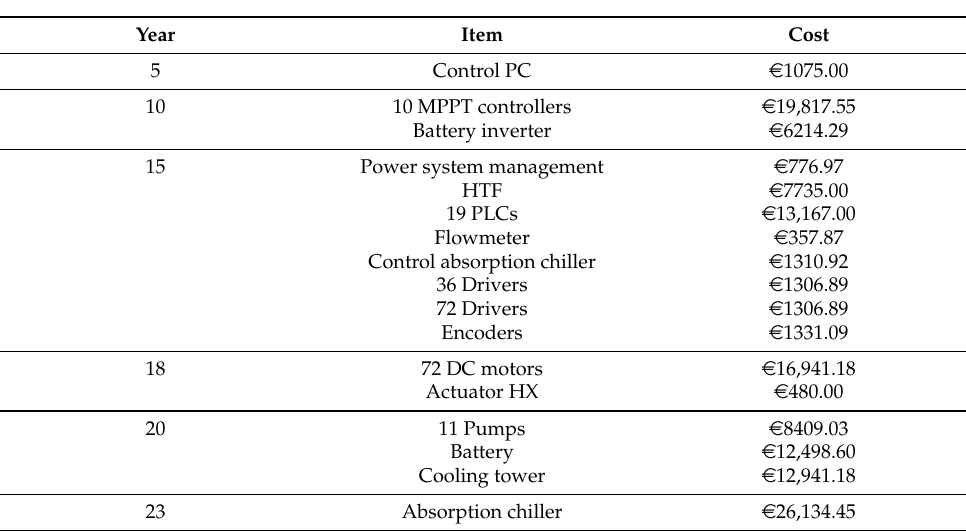
Table 8. Occurrence of the replacement costs C r , t